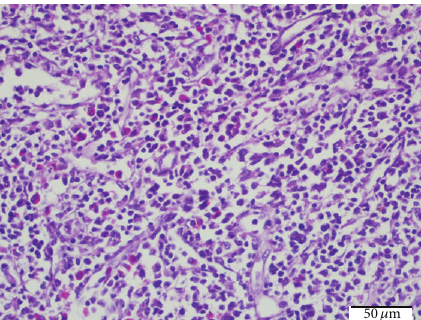
Figure 3: Polymorphic abnormal cells with atypical medium to large sized mononuclear cells admixed with eosinophil precursors (H&E x40).